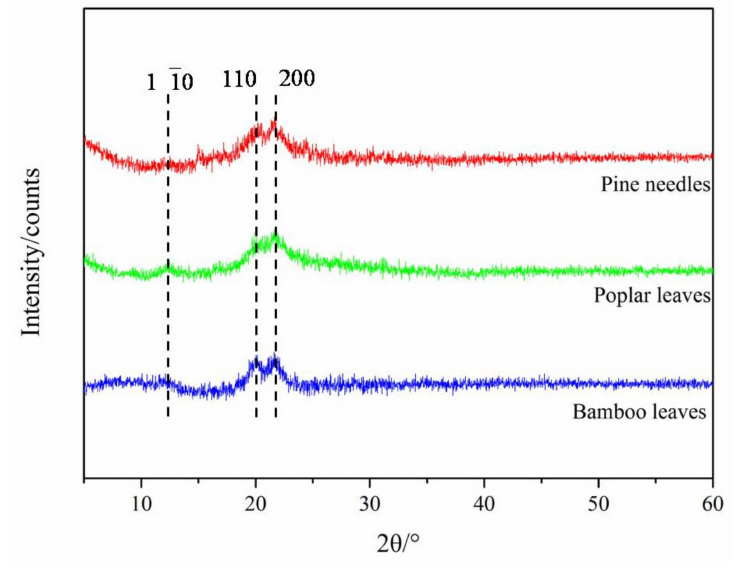
Figure 6. XRD spectra of CNFs prepared from pine needles, poplar leaves, and bamboo